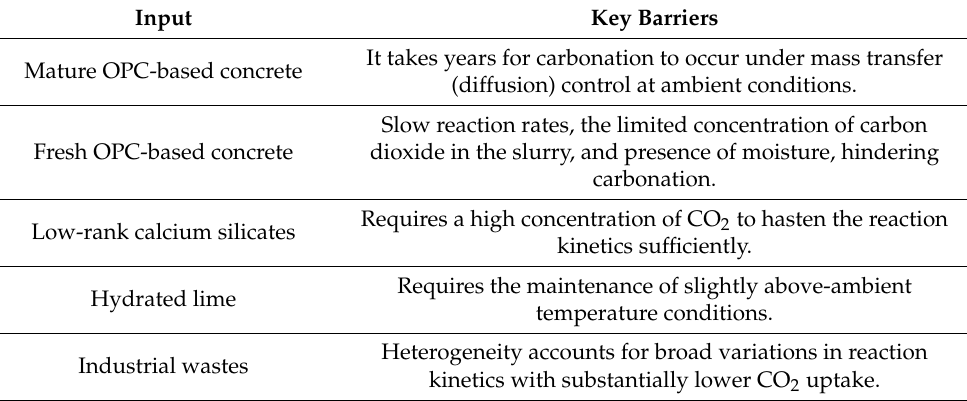
Table 5. Summary of precursor-based barriers faced in mineral carbonation approaches. Adapted with permission from Ref. [127]. Copyright 2022 The National Academies Press. Input Key